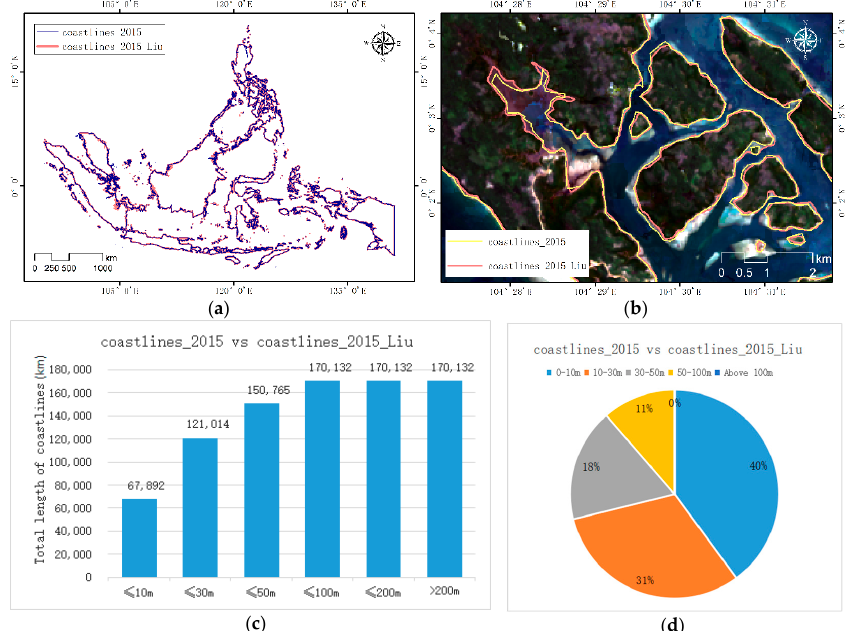
Figure 8. Schematic diagram of accuracy assessment results. ( a ) Overall comparison of the two datasets in 2015; ( b ) comparison of the details of the two datasets in 2015; ( c ) coincidence length of ʺ coastlines_2015 ʺ and ʺ Coastlines_2015_Liu ʺ in different buffer scopes; and ( d ) proportion of ʺ coastlines_2015 ʺ in the length of different accuracies to the total length.